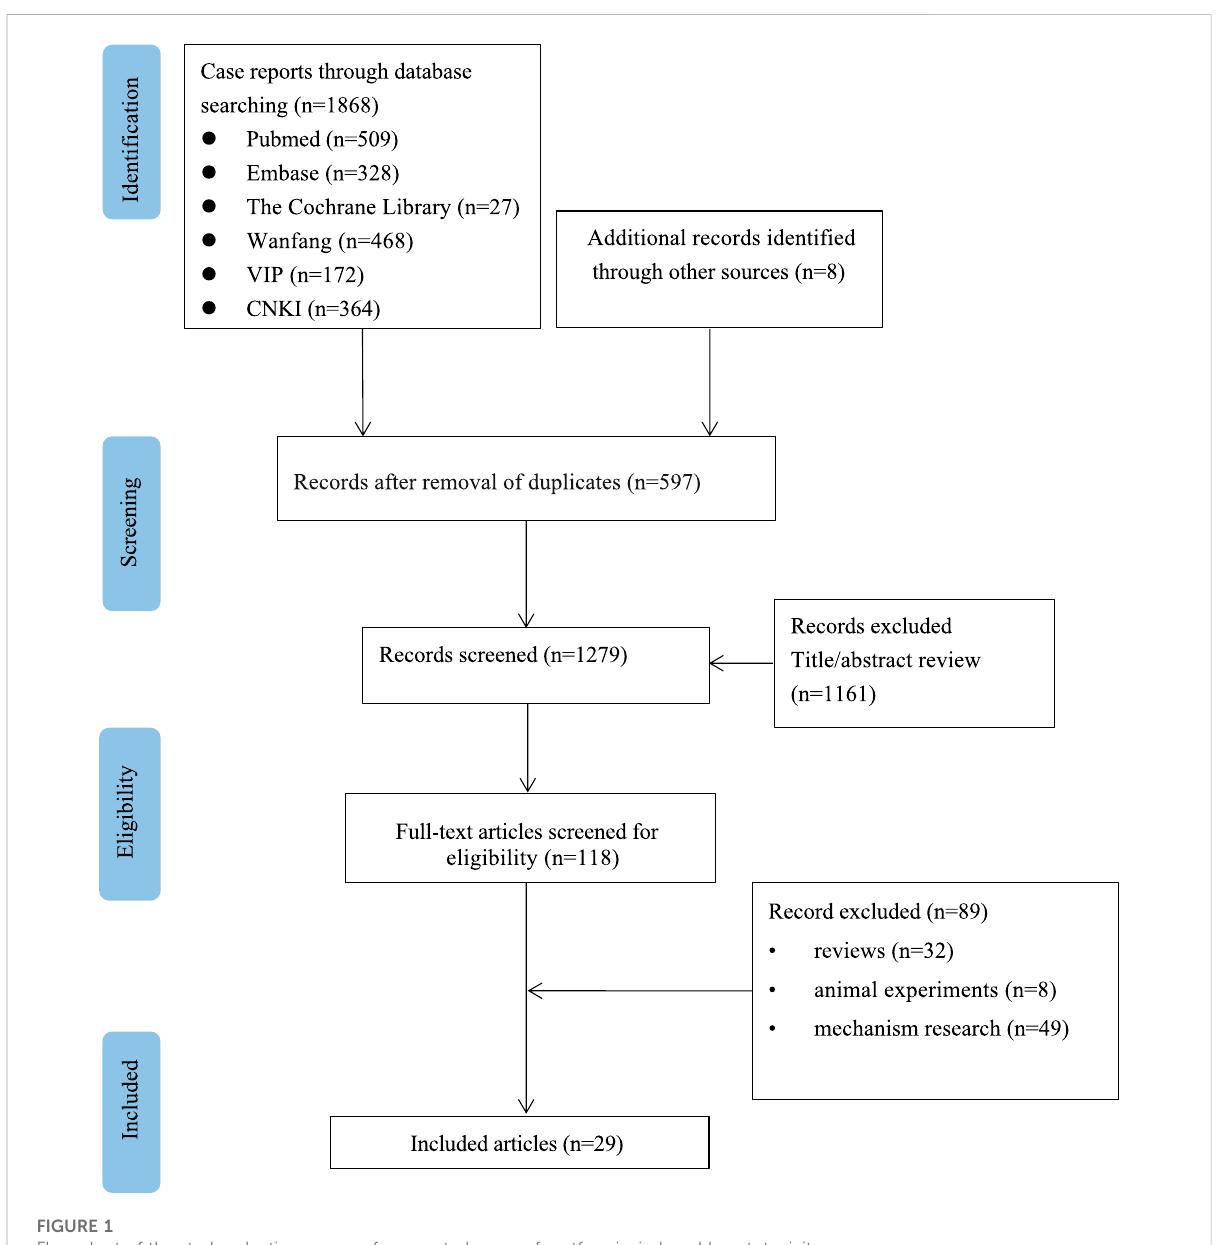
FIGURE 1 Flow chart of the study selection process for reported cases of metformin-induced hepatotoxicity.